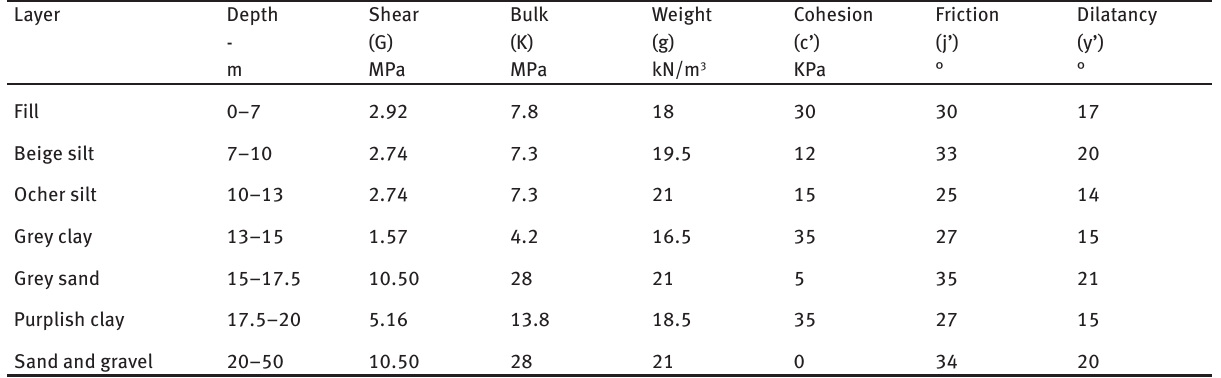
Table 2: Mohr–Coulomb parameters.